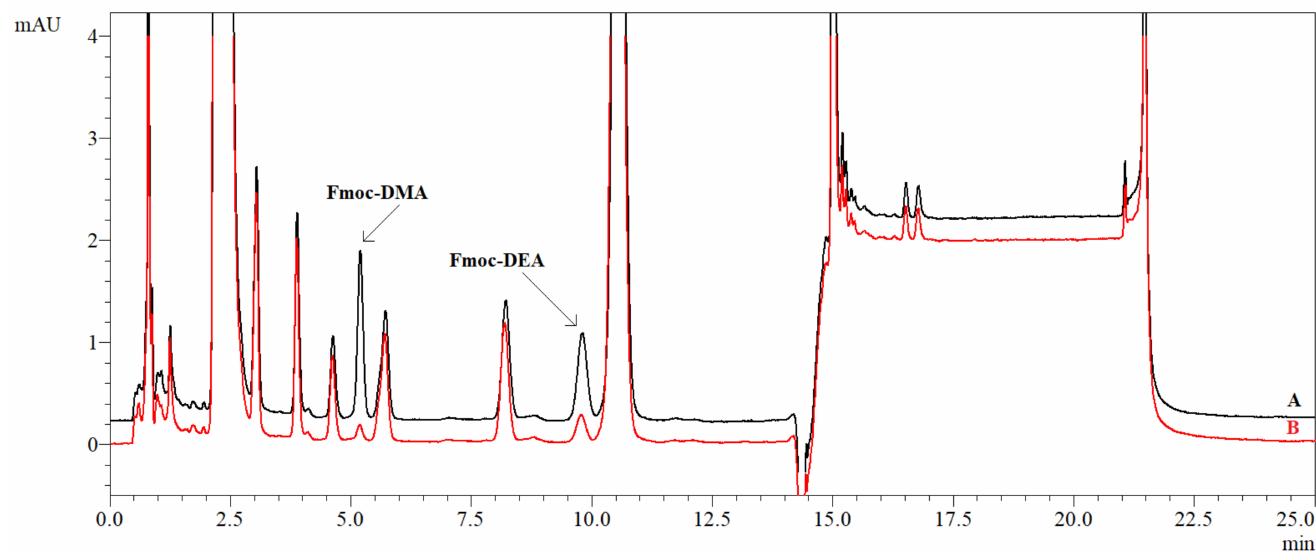
Figure 4. Chromatogram of the 1- µ g/g standard solution of nitrosamines ( A ) and the blank sample ( B ) after derivatisation with Fmoc-Cl (UV-VIS detector, 265 nm; chromatographic conditions as in Table 1).